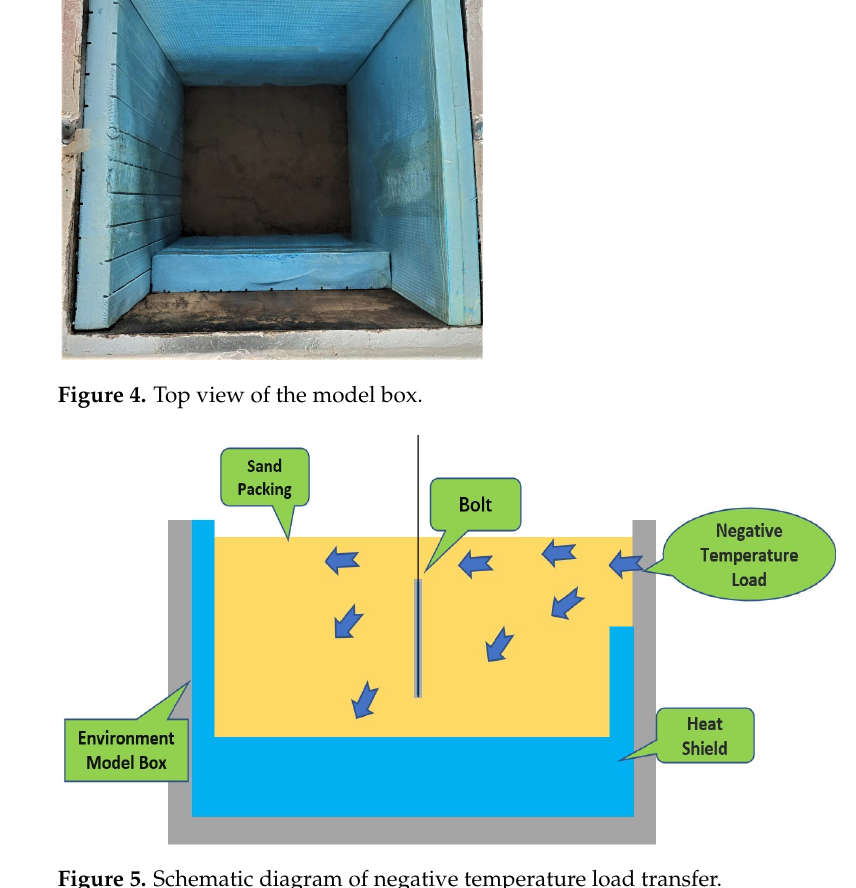
Figure 5. Schematic diagram of negative temperature load transfer.